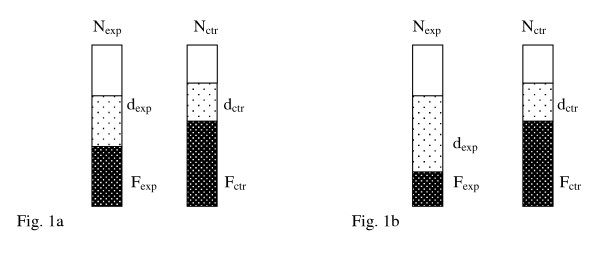
Relative risk of death from causes other than fungal infection in those who survived the fungal infection. Provided the two groups are still comparable after subtraction of fungal deaths from those randomised, the proportion of those who died from another cause than fungal infection would be expected to be the same in the two groups (fig. 1a). If, however, there was a bias in classification of cause of death in favour of the treated group, fewer deaths would be ascribed to fungal infection and more deaths to other causes in this group. This would result in a larger relative risk of death for those who did not die from fungal infection (fig. 1b). This risk is an estimate of bias overall: RR = (dexp/(Nexp-Fexp))/(dctr/(Nctr-Fctr)), where exp: experimental group; ctr: control group; Nexp, Nctr: numbers of randomised patients; Fexp, Fctr: numbers of deaths from fungal infection; dexp, dctr: numbers of deaths from causes other than fungal infection.